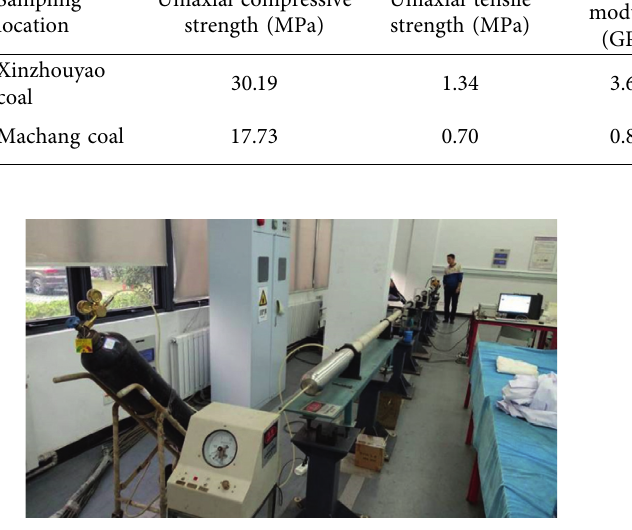
Figure 1: Photograph of the used Split Hopkinson Pressure Bar (SHPB)